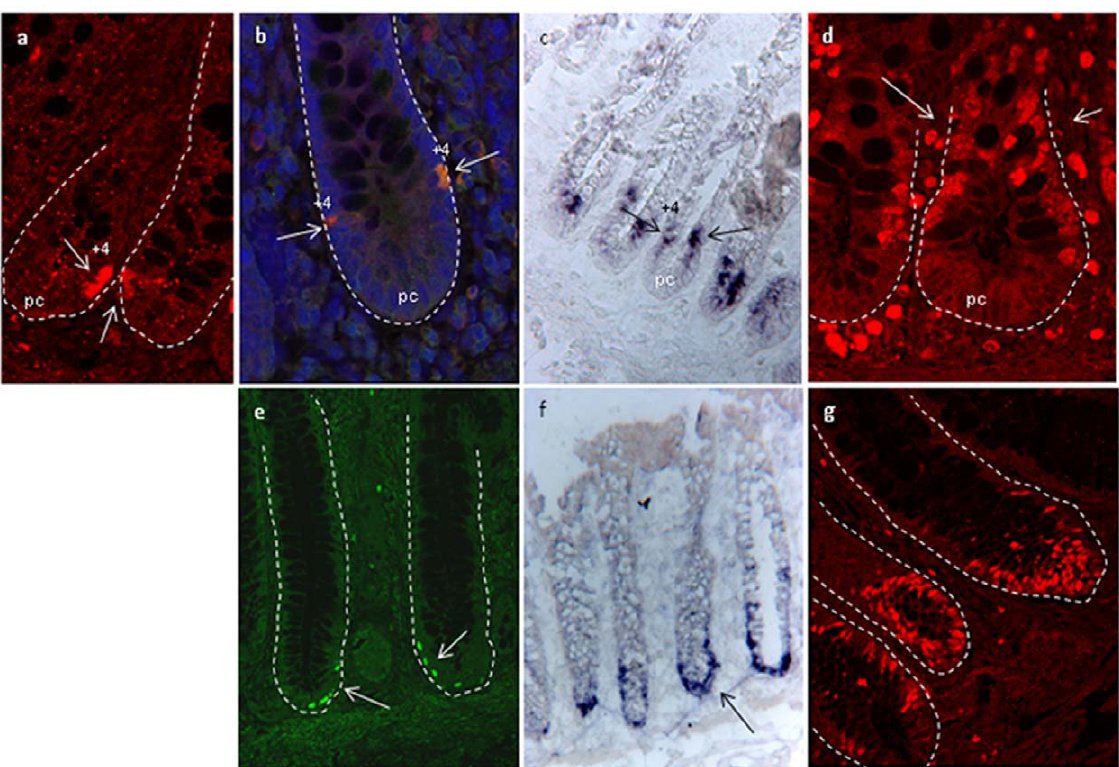
Figure 1. Identification of putative stem cells . Paraffin sections of normal human small intestinal tissue were prepared for immunohistochemical analysis with a) anti-CD133 antibody identifies several positive cells from + 4 position and upwards (indicated by arrows), b) anti-Lgr5 antibody identify positive cells in + 4 positions (indicated by arrows). The nuclei were stained with Hoechst 33342, c) In situ hybridization of normal human small intestine for Olfm4 reveals an expression pattern similar to the expression of Lgr5, in the + 4 position, d) Sections of normal human small intestinal tissue were prepared for immunohistochemical analysis with anti-Ki67 antibody to identify proliferating cells. Positive cells are indicated with arrows (pa = Paneth cells), e) Paraffin sections of normal human colon tissue were prepared for immunohistochemical analysis with anti-Lgr5 antibody, and positive cells are identified in the crypt base (indicated by arrows), f) In situ hybridization of normal human colon for Olfm4 reveals an expression pattern similar to the expression of Lgr5 at the crypt base. g) Sections of normal human colon tissue were prepared for immunohistochemical analysis with anti-Ki67 antibody to identify proliferating cells.